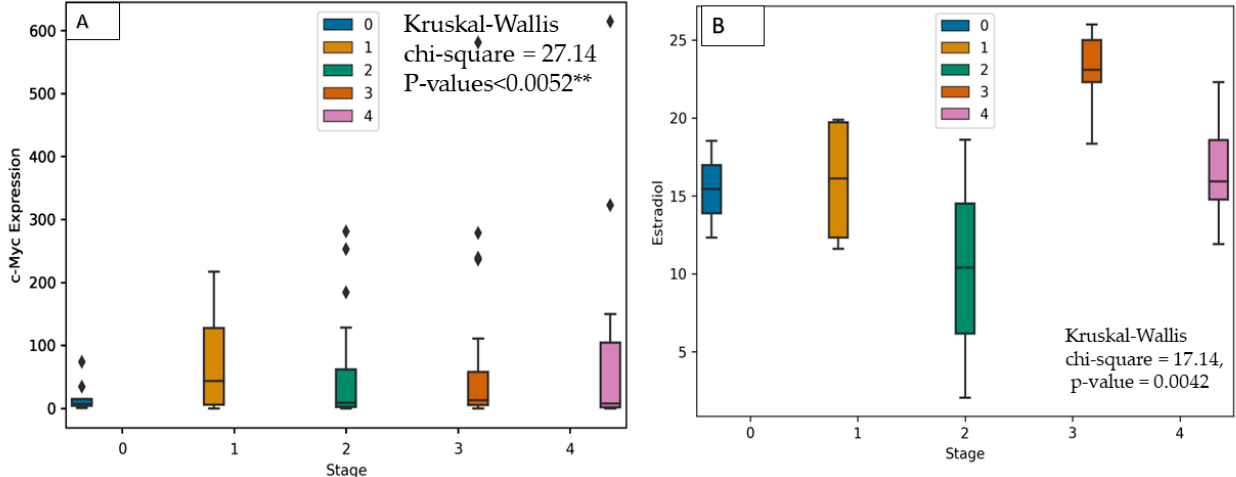
Figure 9. c-myc and estradiol’s relative expression at different stages of breast cancer. ( A ) c-myc expression at each stage of breast cancer. Stage III of breast cancer showed a noticeably high level of c-myc. A Kruskal–Wallis test was performed; Stages III and IV showed a significant relation to c-myc expression p -values > 0.05 and >0.0052, respectively. ( B ) Box-and-whisker graph showed estradiol level at each stage of breast cancer. Stage III of breast cancer showed a noticeably high level of estradiol. Kruskal–Wallis chi-square = 17.14, df = 5, p -value = 0.0042.